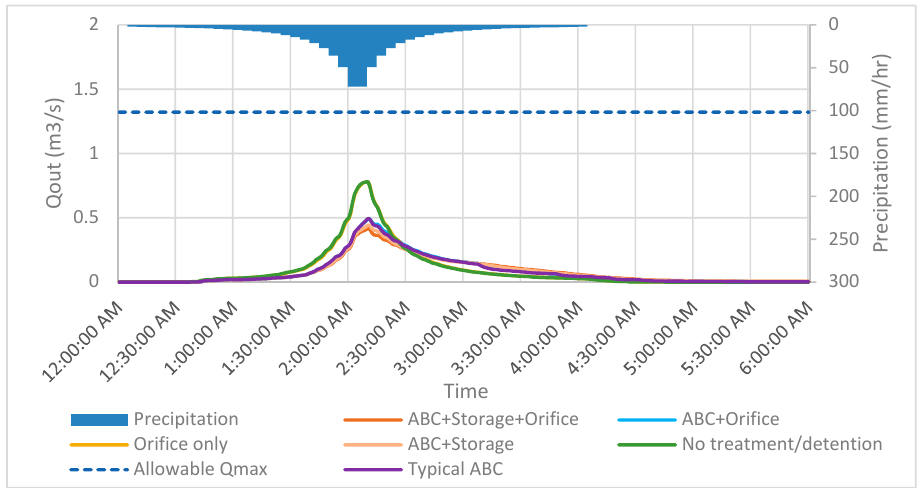
Figure 11. Outflow results of the precinct and alternative scenarios for the 3-month design storm.